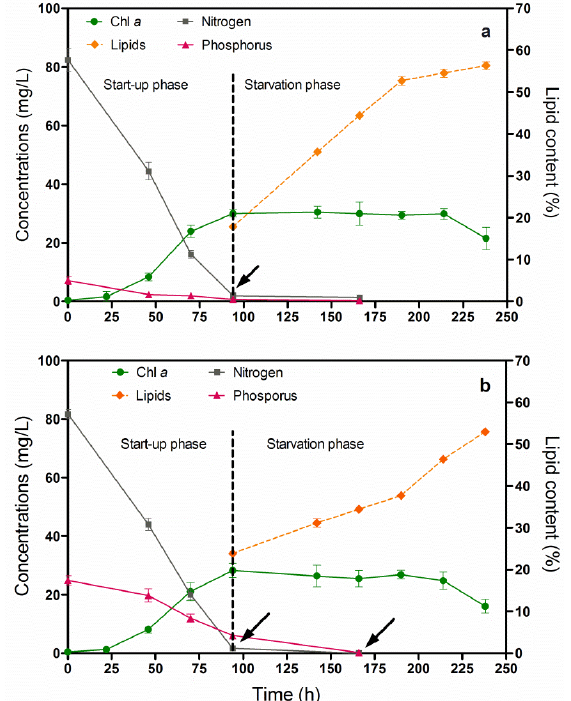
Figure 3. Changes in the Chl-a concentration and lipid content versus time, of Chlorella vulgaris CCALA 896 grown under batch growth conditions using the modified BG-11 medium ( a ) and modified Kolkwitz medium ( b ). The nitrogen (N) and phosphorus (P) concentrations were checked as well. The lipid content in the Chlorella biomass was checked, starting from the N and P starvation conditions, which are indicated by the